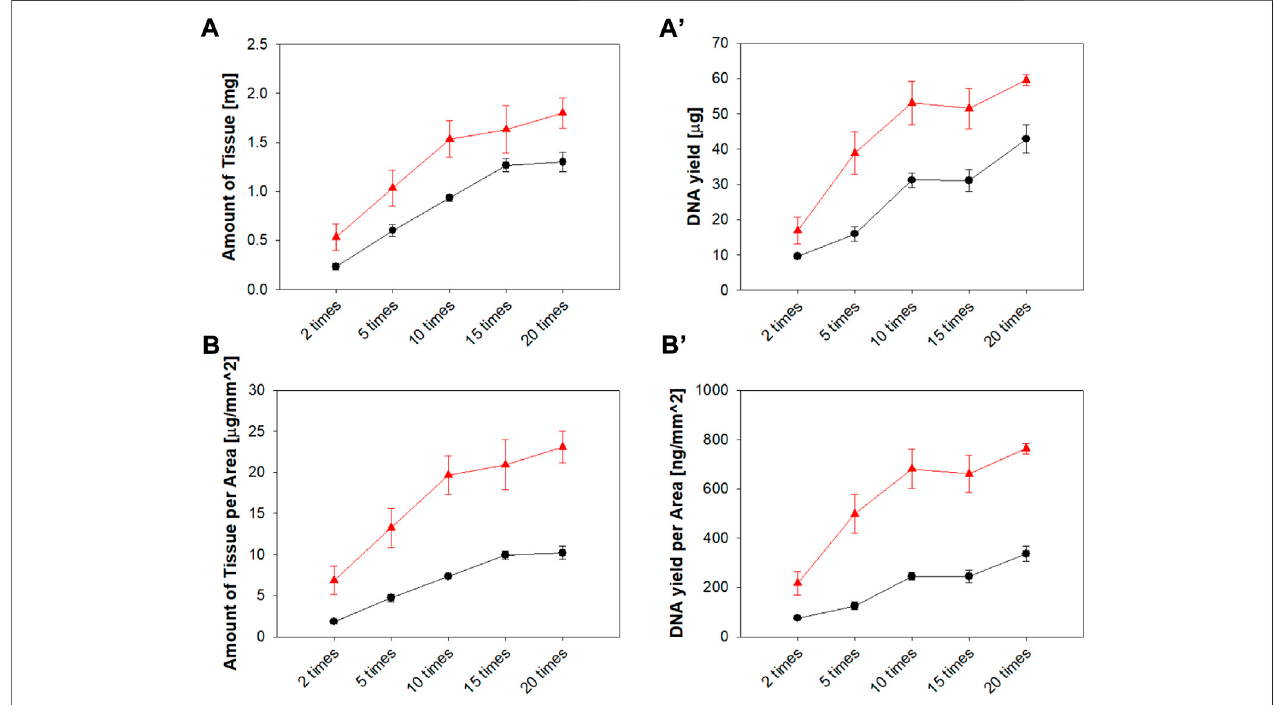
FIGURE10 |(A) ComparisonofDNAyieldaccordingtomicroneedlepattern(S:straight,Z:zigzag).Thesharpnessofbothmodelsequals20 μ m(S-N4-I2-S20,Z-N4- I2-S20). (B) Comparison of DNA yield according to the number of microneedles (Z-N4-I2, Z-N2-I2) and the interval between microneedles (Z-N2-I2, Z-N2-I4) (n = 3).